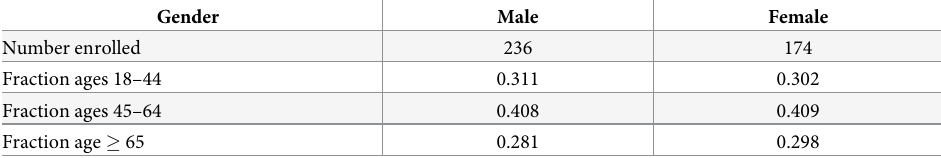
Table 1. Gender and age distributions of enrolled